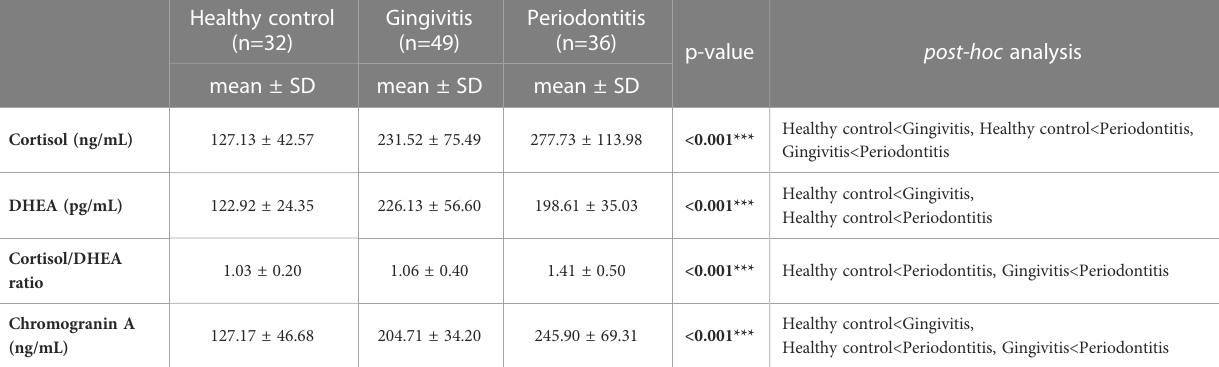
TABLE 3 Multivariate logistic regression analysis of cortisol, cortisol/dehydroepiandrosterone ratio, and chromogranin A values.